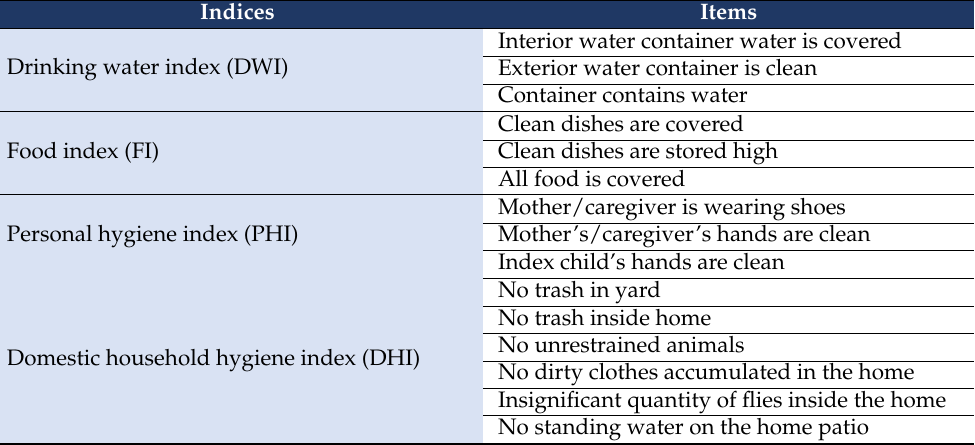
Table 1. Indices and items in the sanitation